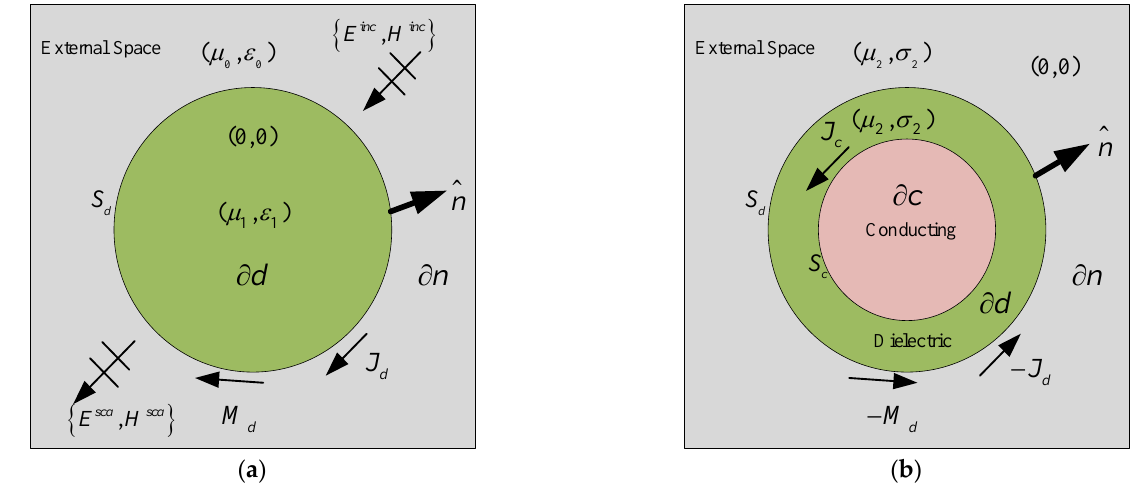
Figure 3. ( a ) Equivalent external problem ( b ); equivalent interior situation.